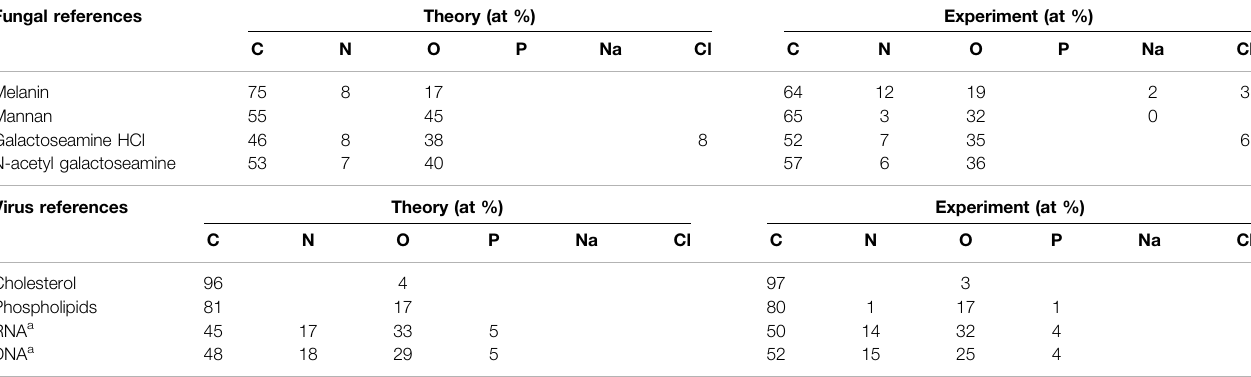
a Average of idealized structure consisting of equal amounts of nucleotides.